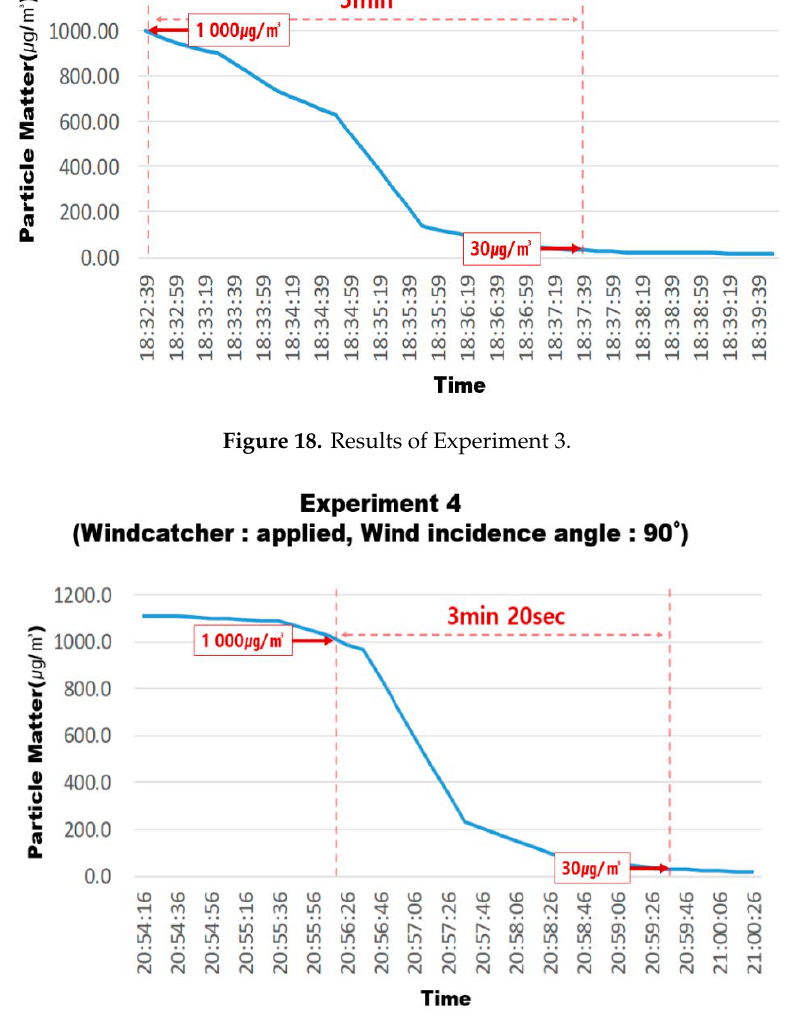
Figure 19. Results of Experiment 4.